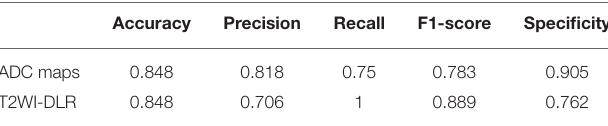
TABLE 4 | Clinical ADC maps vs. our model.